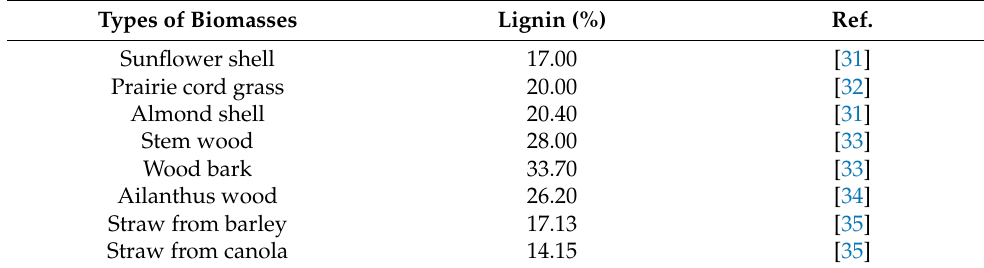
Table 1. Percentages of lignin in various lignocellulose.